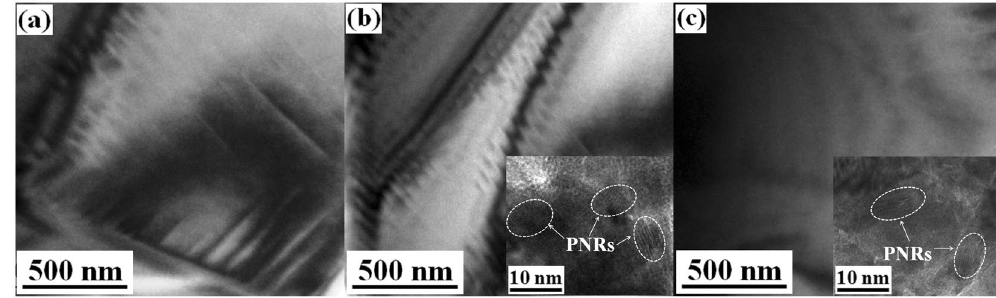
Figure 4. TEM images of ( a ) BTSn11, ( b ) BTSn15 and ( c ) BTSn20 at room temperature.